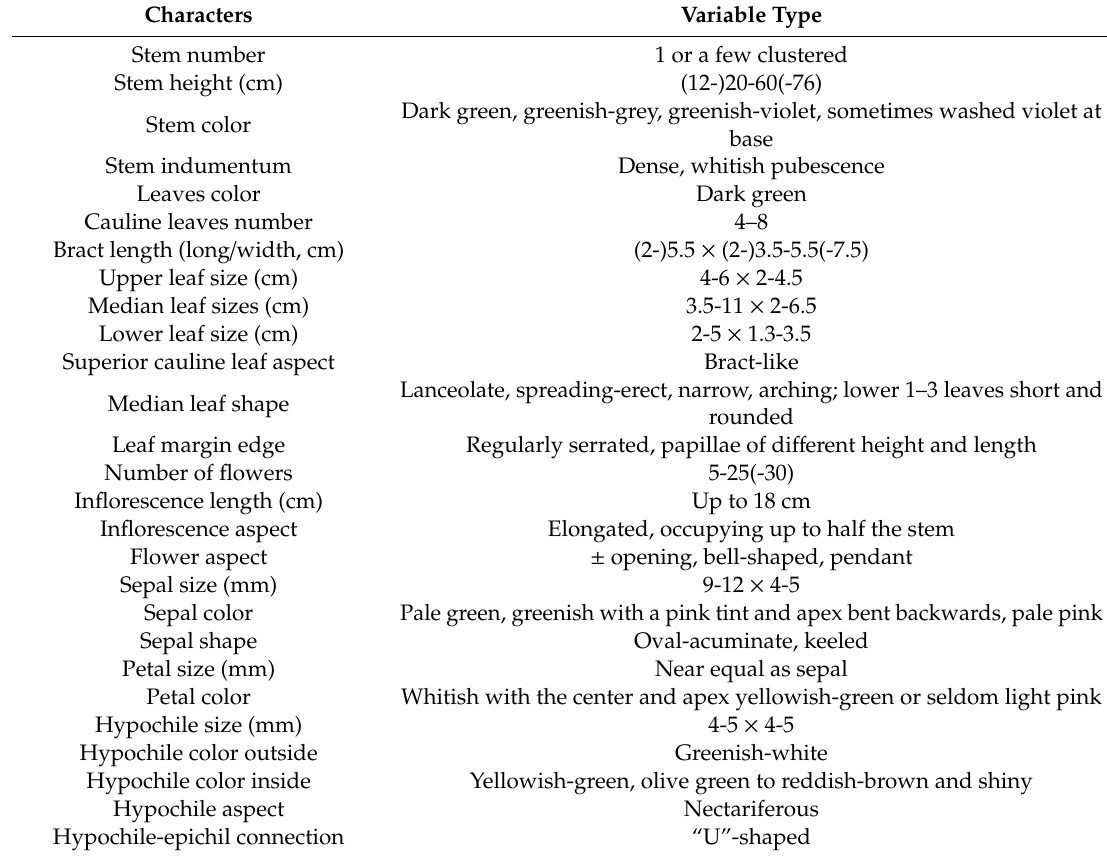
Table 1. Morphological features of Epipactis greuteri .